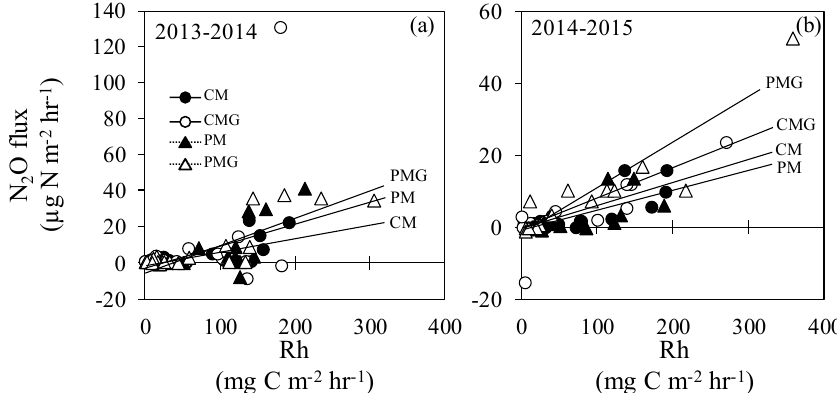
Figure 5. Relationship between heterotrophic respiration (Rh) and N 2 O flux in fallow season in the 302 first (a) and second (b) years. 303